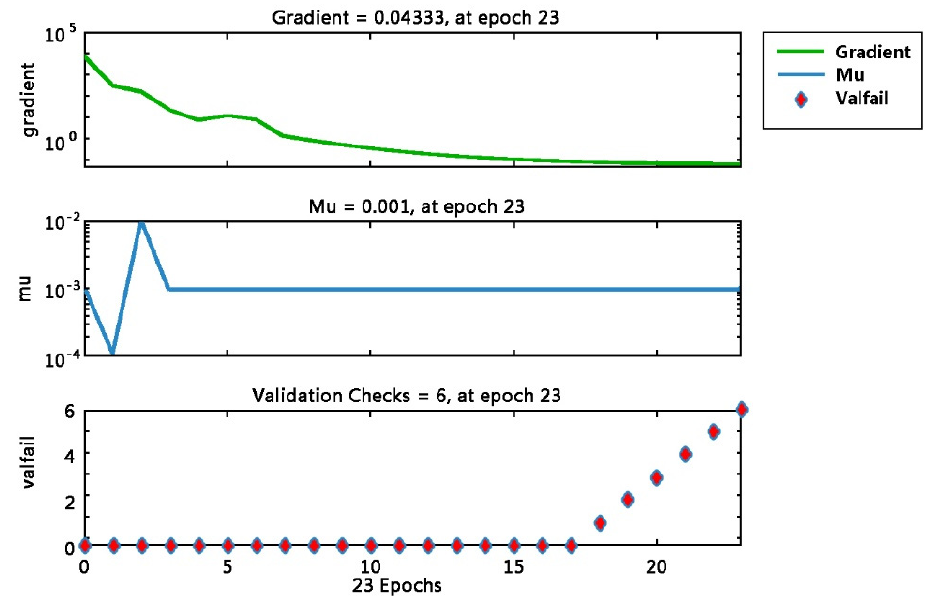
Figure 2. Gradient and validation checks at